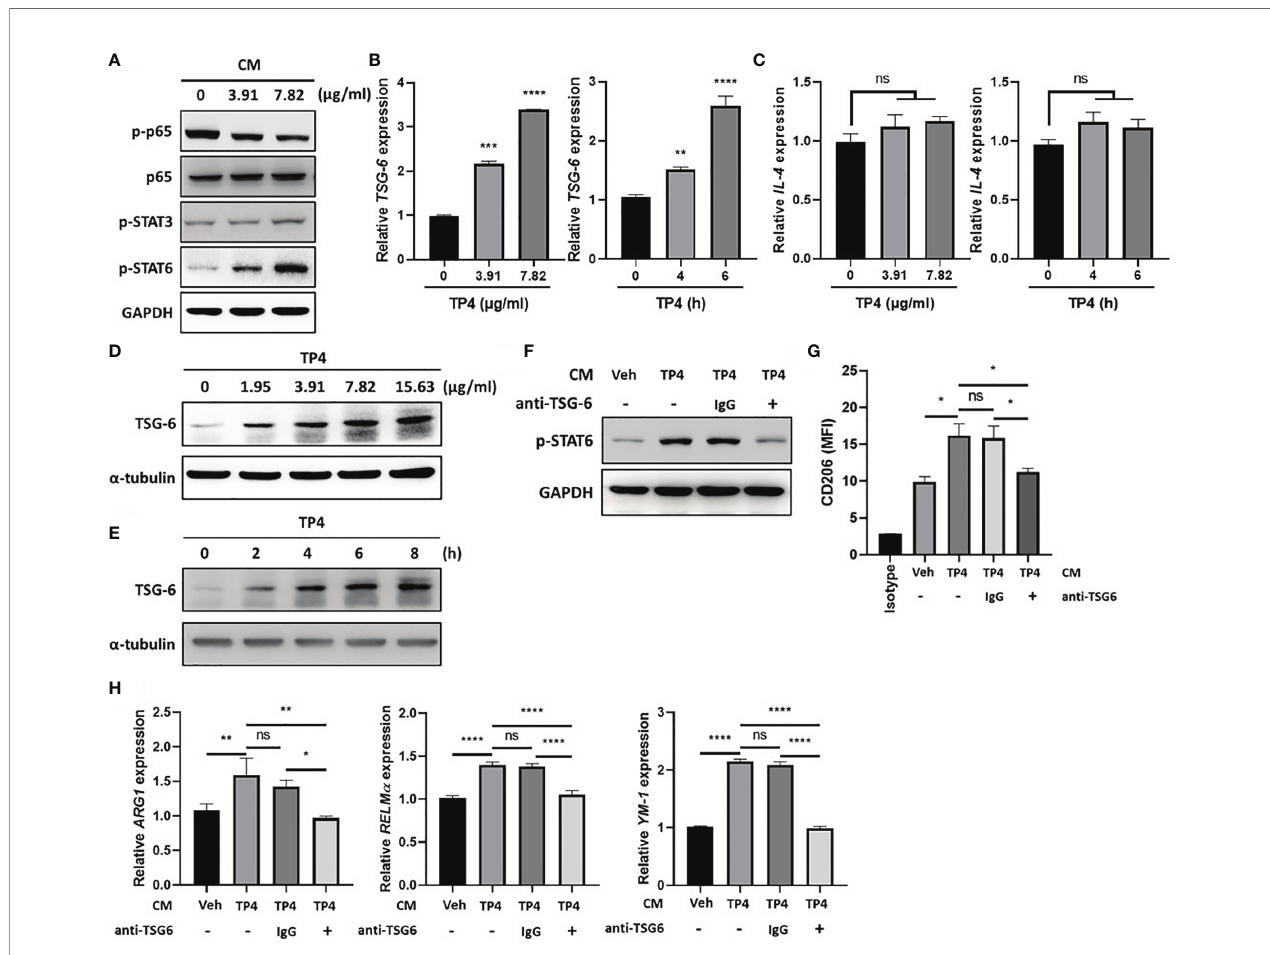
FIGURE 7 | TP4-induced TNF- a -stimulated gene 6 (TSG-6) secretion from VK2 cells is required for STAT6 activation in THP-1/GV cells. (A) Detection of phosphorylated NF k B p65 subunit (p-p65), STAT3 (p-STAT3), and STAT6 (p-STAT6) after 1 h treatment with conditioned medium (CM) from TP4 (3.91 or 7.82 m g/ ml)-treated VK2 cells to THP-1/GV cells by immunoblotting. GAPDH was used as an internal control to show equal protein loading. (B) TSG-6 expression in VK2 cells after TP4 (3.91 or 7.82 m g/ml) treatment for 6 h (left) or 7.82 m g/ml TP4 treatments for 0, 4 or 6 h (right), measured by qRT-PCR. Data were represented